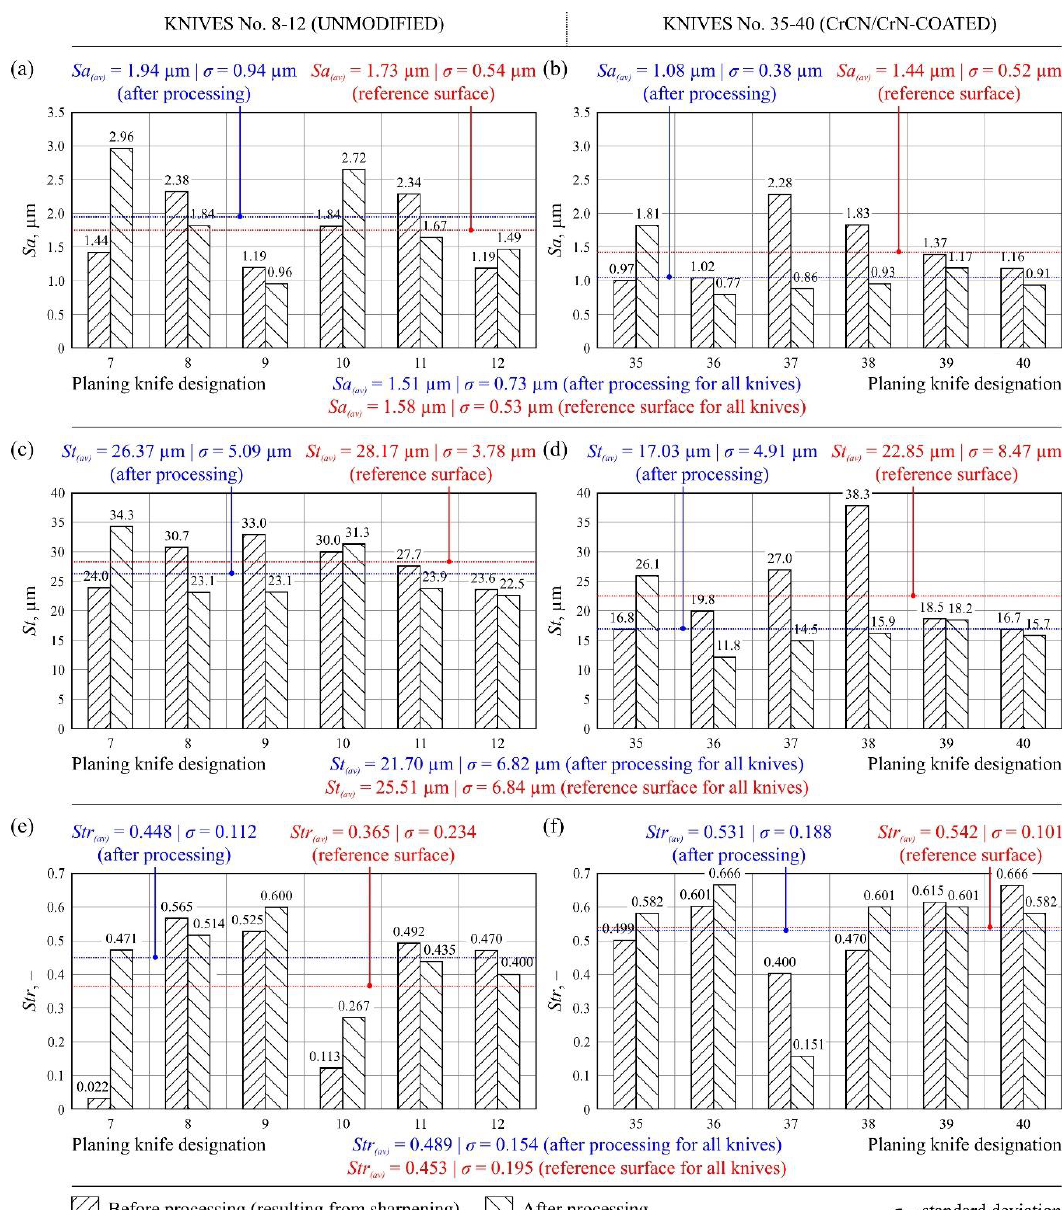
Figure 11. Values of texture parameters of the rake faces of ( a , c , e ) unmodified knives No. 7–12 and ( b , d , f ) CrCN / CrN-coated knives No. 35–40: ( a , b ) arithmetic mean deviation of the surface ( Sa ); ( c , d ) total height of the surface ( St ); ( e , f ) texture aspect ratio of the surface ( Str